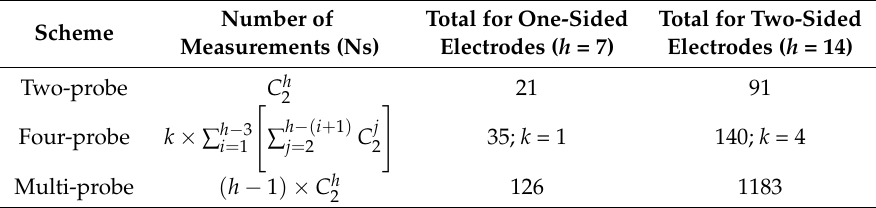
Table 1. Number of measurements/combinations for the measuring schemes used for